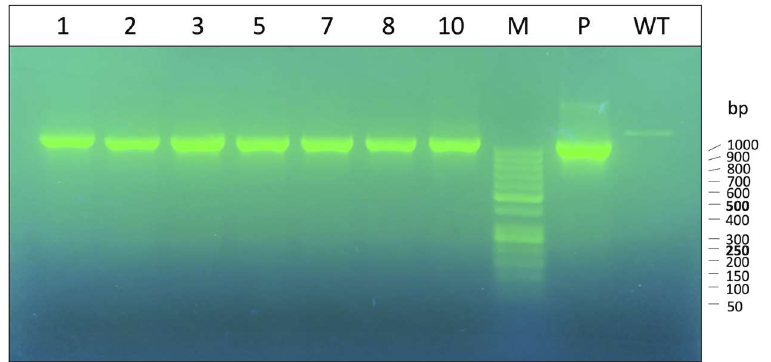
Figure 1. Check on Agarose gel of PCR products of obtained clones. The α-globin insert of the plasmid was amplified using primers on the plasmid sequence, ensuring that α-globin product came from cloning and not from K562 genome. We also amplified pcDNA3.1Hygro(+)-α-globin (P) as a positive control and K562 WT DNA as a negative control. Marker (M) graduation is displayed at the right of the gel image.